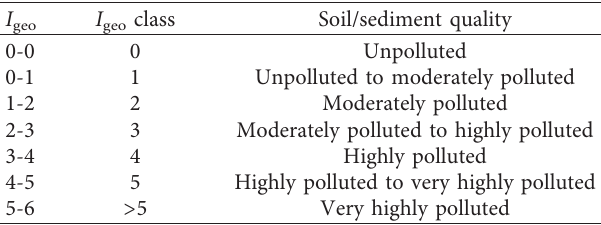
Table 1: Classes of geoaccumulation index (Muller,